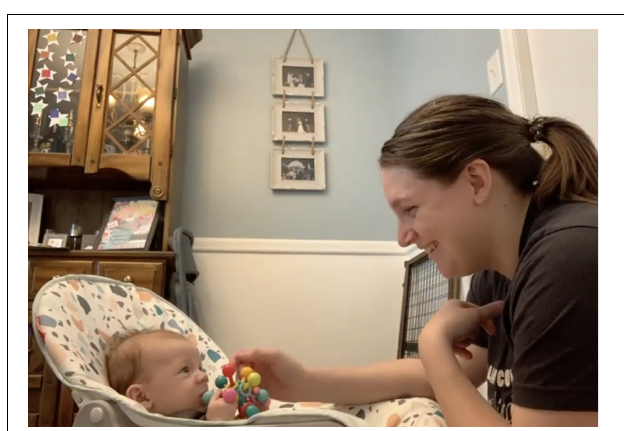
FIGURE 8 | Data from a peek-a-boo game.